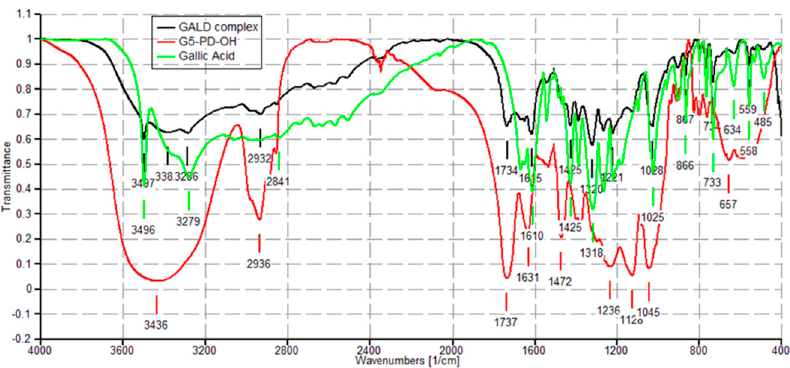
Figure 4. FTIR spectra of dendrimer 4 (red), GA (green) and GALD 7 (black).